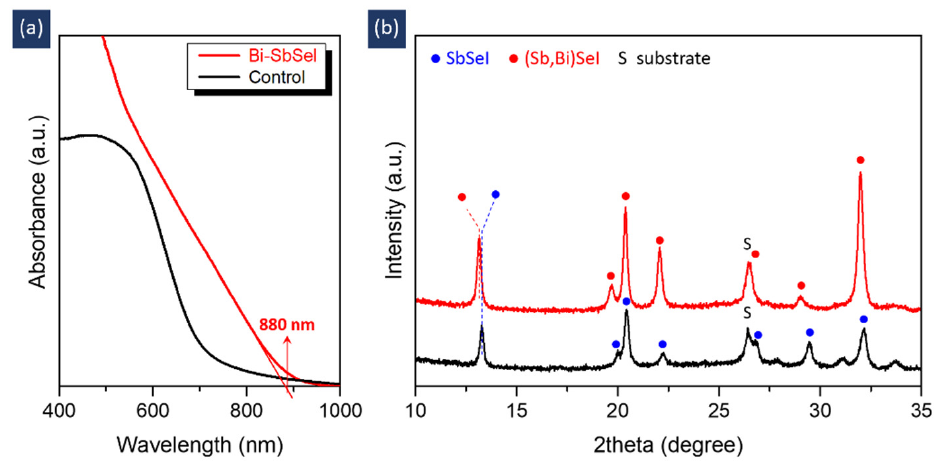
Figure 4. ( a ) Absorption spectra and ( b ) XRD patterns of control and Bi-SbSeI samples.